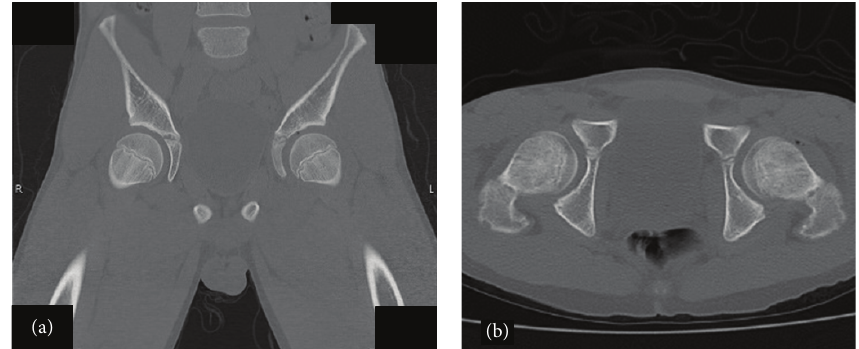
Figure 3: Coronal (a) and axial (b) CT scan after reduction shows the left femoral head correctly positioned in the acetabulum with no fractures or interposition of osteochondral fragments.